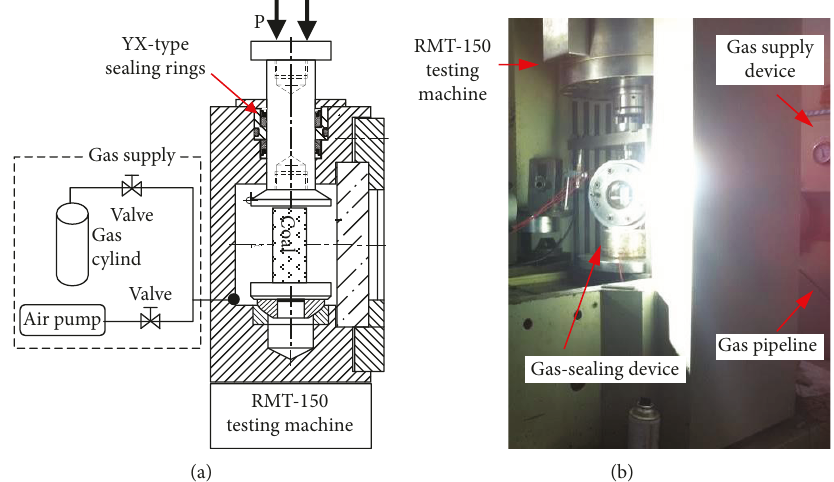
Figure 2: Experimental system for gas-containing coal schematics (a) and device (b).